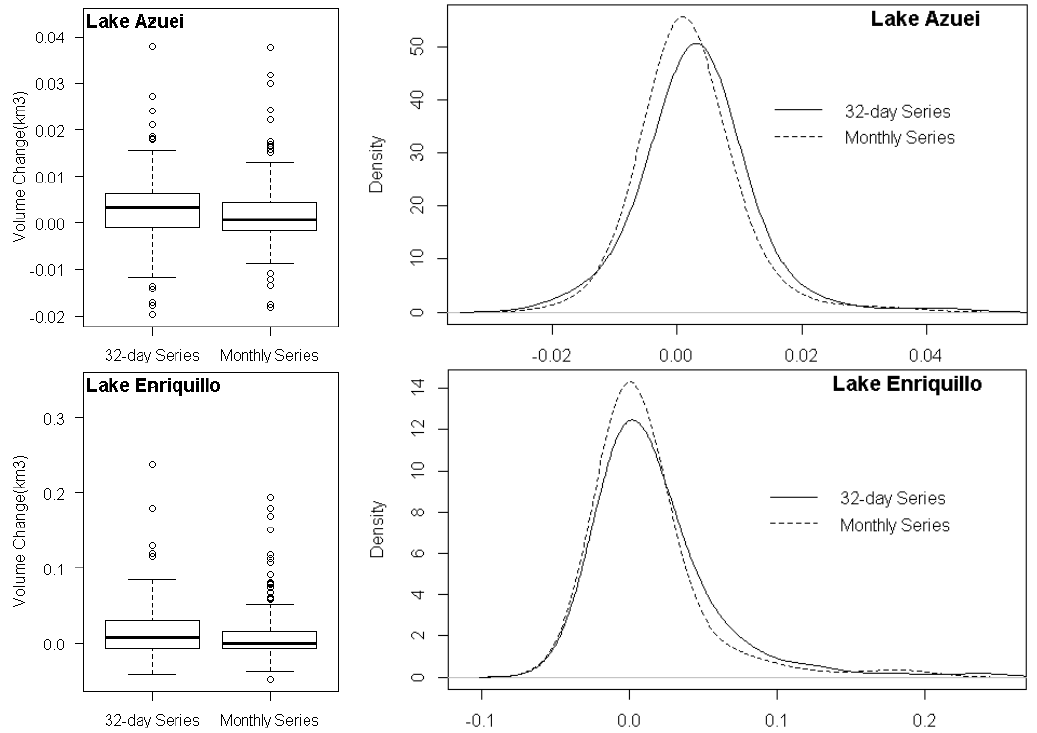
Figure 6. Comparison of the 32-day and monthly volume change datasets boxplot and distribution. Table 2. Statistical variables of the lakes volume change datasets.